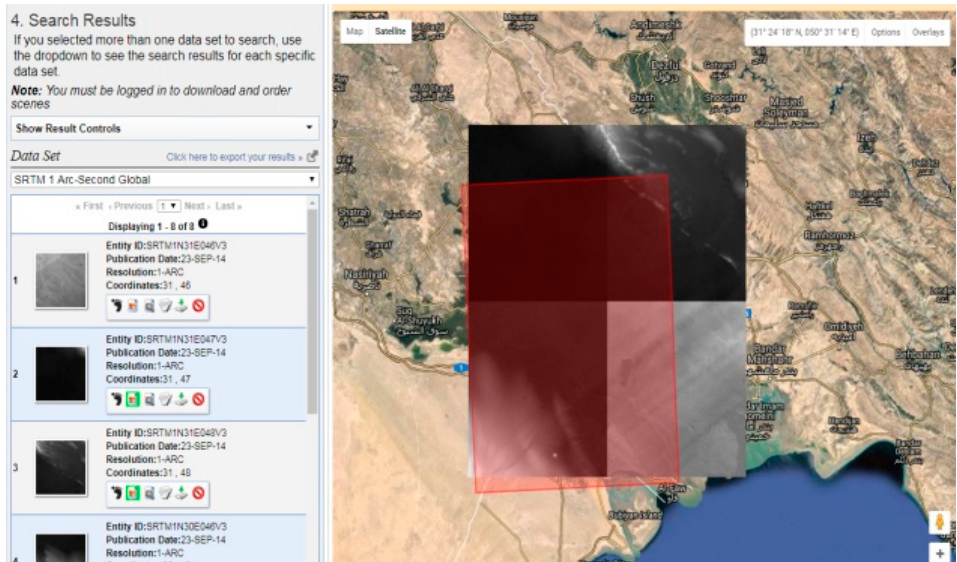
Figure 7. DEM from United States Geological Survey (USGS )website [27].